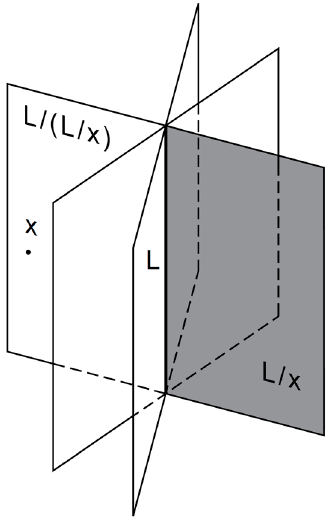
Figure 4. Example 26.